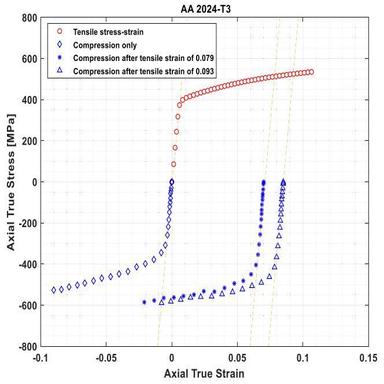
Experimental stress-strain curves in pre-tension and compression for AA 2024-T3.